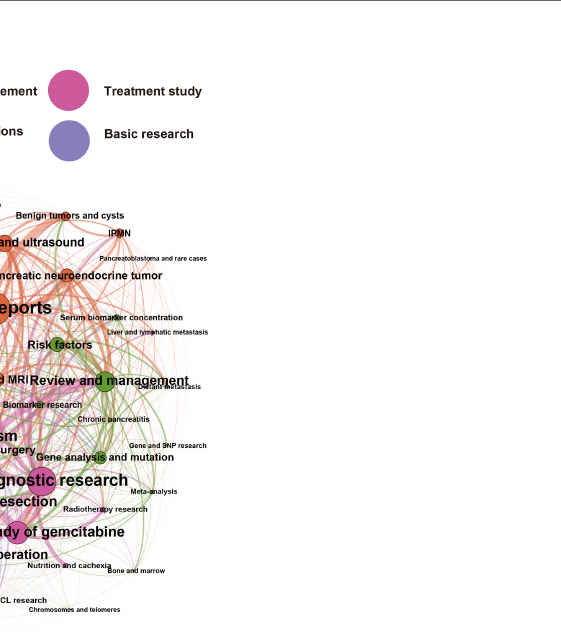
FIGURE 5 | The main areas in pancreatic cancer research over the last 25 years are “ Treatment Studies ” , “ Clinical Manifestations and Diagnosis ” , “ Review and Management ” , and “ Basic Research ” . We analyzed pancreatic cancer publications from the last 25 years using the LDA algorithm, from which 50 topics were identi fi ed and classi fi ed into four broad categories: “ Clinical Manifestations and Diagnosis ” (orange), “ Review and Management ” (green), “ Treatment Study ” (pink), and “ Basic Research ” (purple). The circle size represents the number of publications contained in the research topic. For example, the algorithm found that the topic case reports contain 3,791 publications. The line thickness between the circles represents the degree of overlap between the two research topics, such as the 989 publications with the highest degree of overlap in “ Operation and postoperation ” and “ Laparoscopy surgery ”